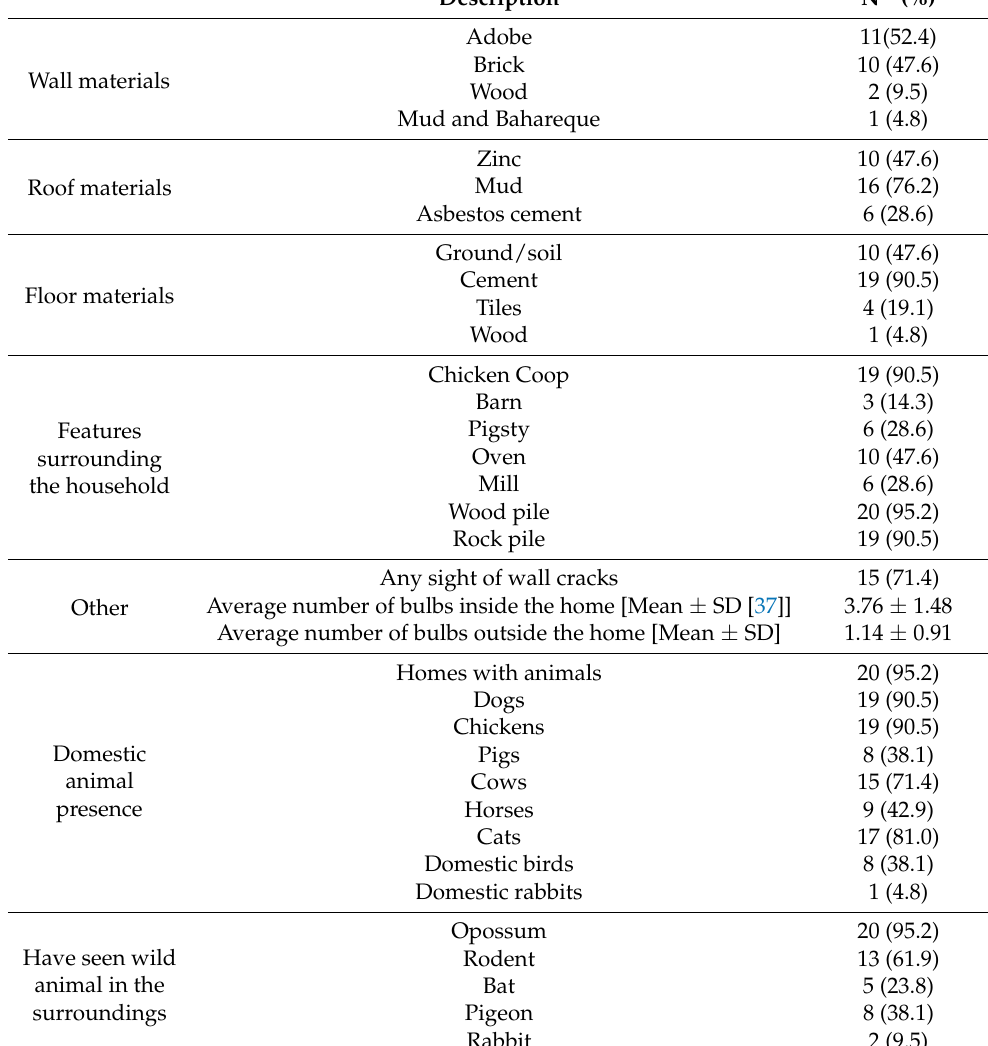
Table 2. Description of household